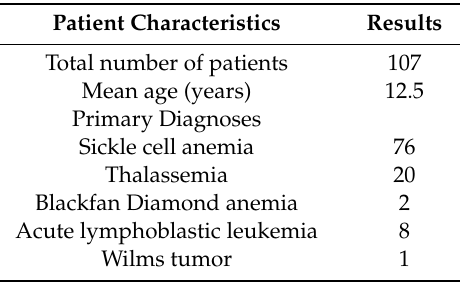
Table 1. Demographic